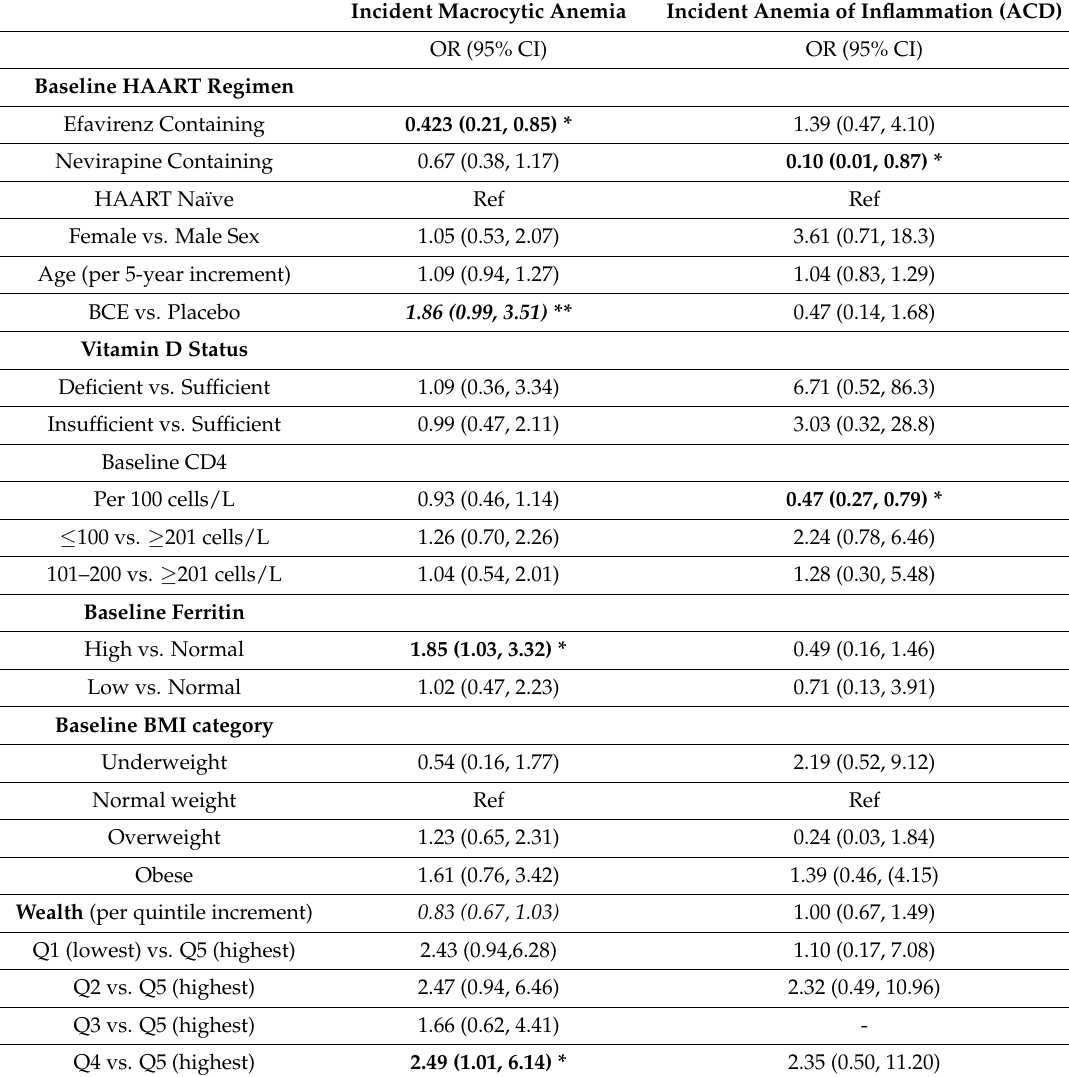
Table 3. The predictors of Incident Macrocytic anemia and Anemia of Chronic Disease over 18 months Follow-up among Ugandan adults free of anemia at